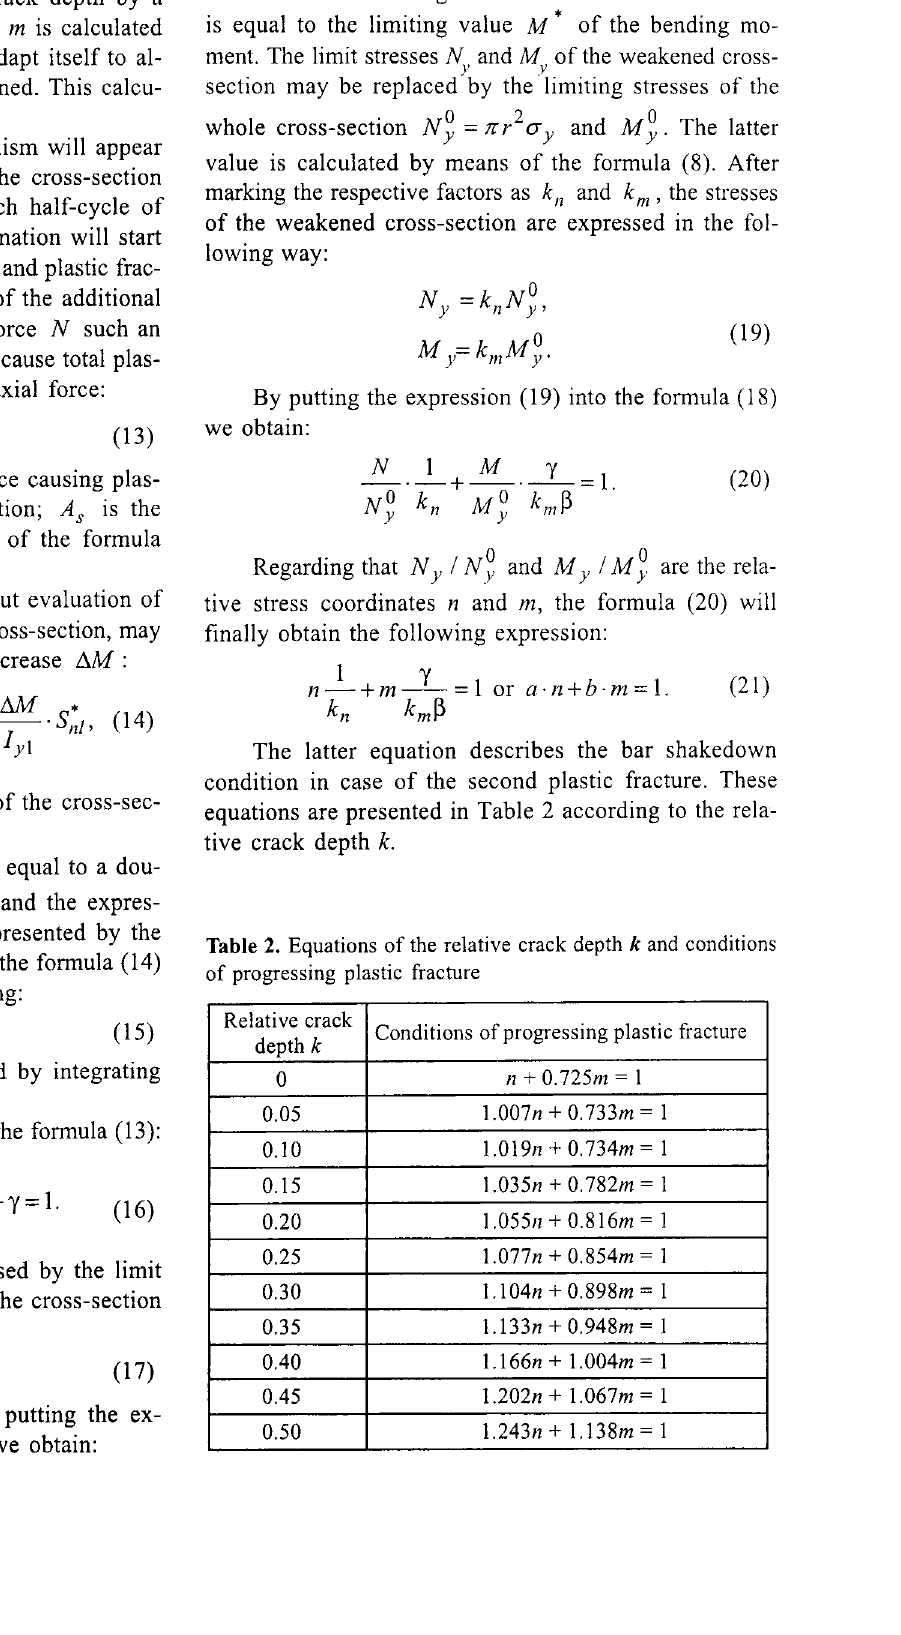
Table 2. Equations of the relative crack depth k and